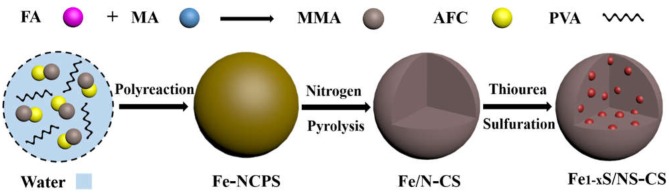
Schematic demonstration of the formation process of Fe1−xS/NS-CS.